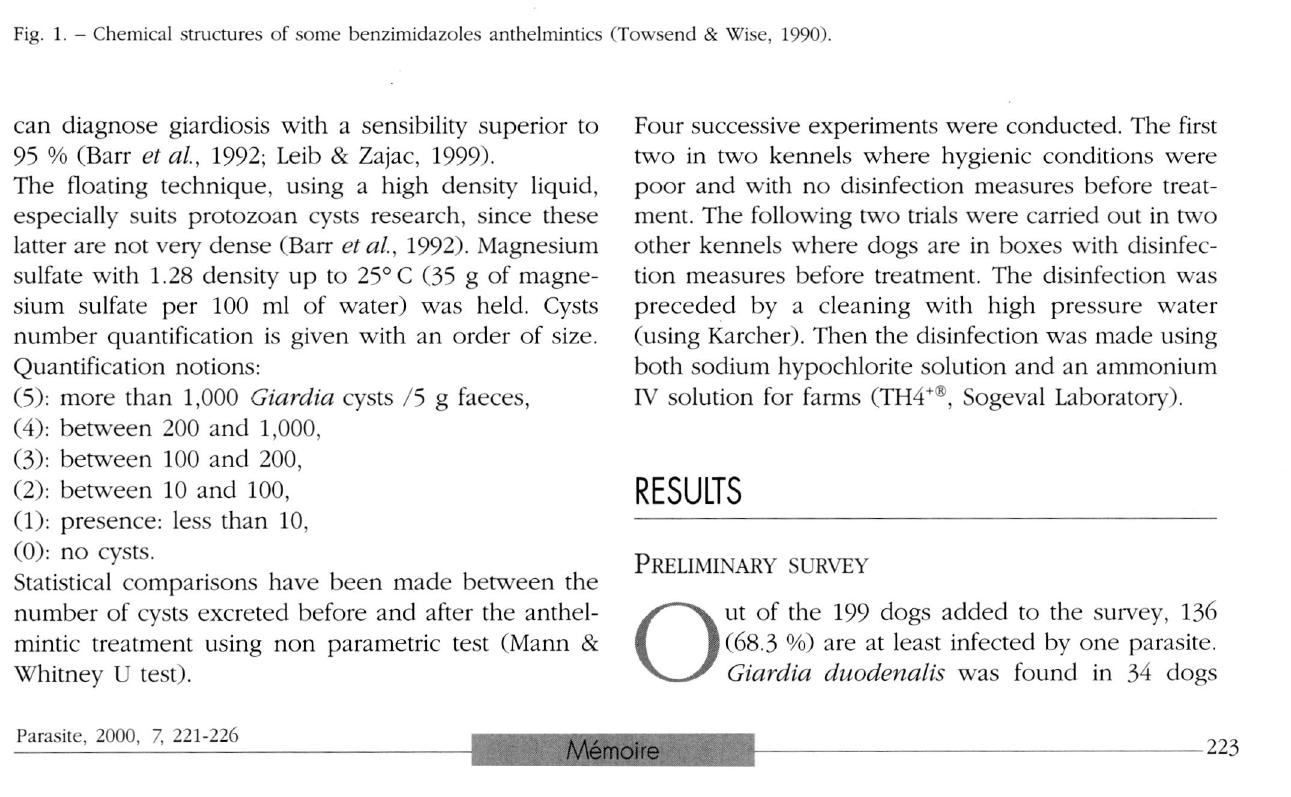
Fig. 1. - Chemical structures of some benzimidazoles anthelmintics (Towsend & Wise, 1990).